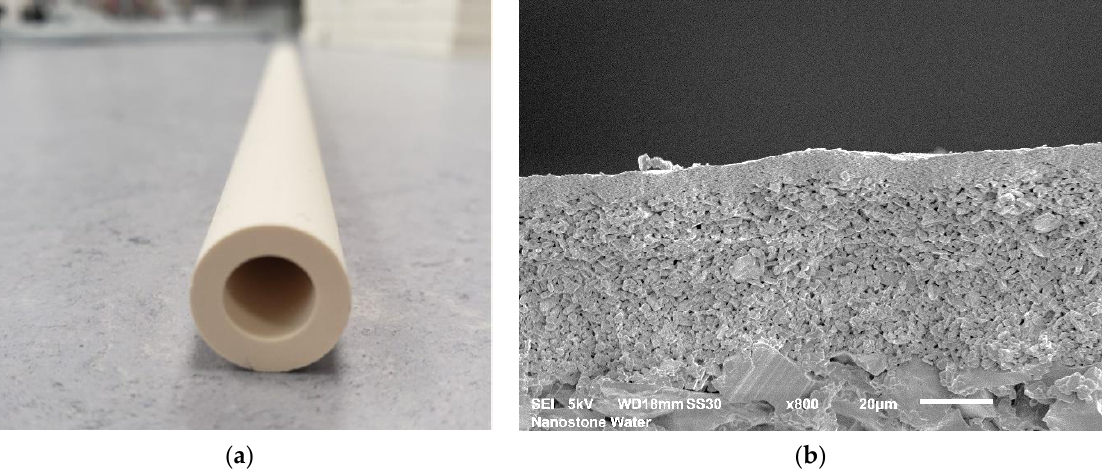
Figure 2. Single-channel ceramic segment: ( a ) monotube ceramic membrane with dimensions of length of 300 mm; height of 14.0 mm; wall thickness of 3.0 mm; and channel diameter of 8.0 mm and ( b ) SEM picture of the ceramic membrane. Shown is the substrate being coated with two defined ceramic membranes to reach a final pore size of 30 nm.